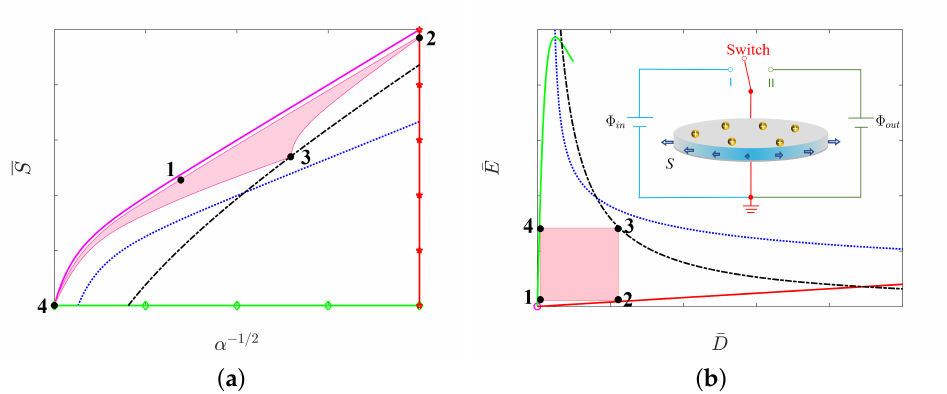
Figure 5. The cycle of energy harvesting is represented by the boundary of a shaded area in either ( a ) the dimensionless stress vs. strain plane or ( b ) the nominal electric field vs. nominal electric displacement plane. In ( b ), four sides 12 , 23 , 34 and 41 of the rectangle represent different steps of the process of energy harvesting. The detailed four steps of the soft energy harvester have been illustrated in Figure